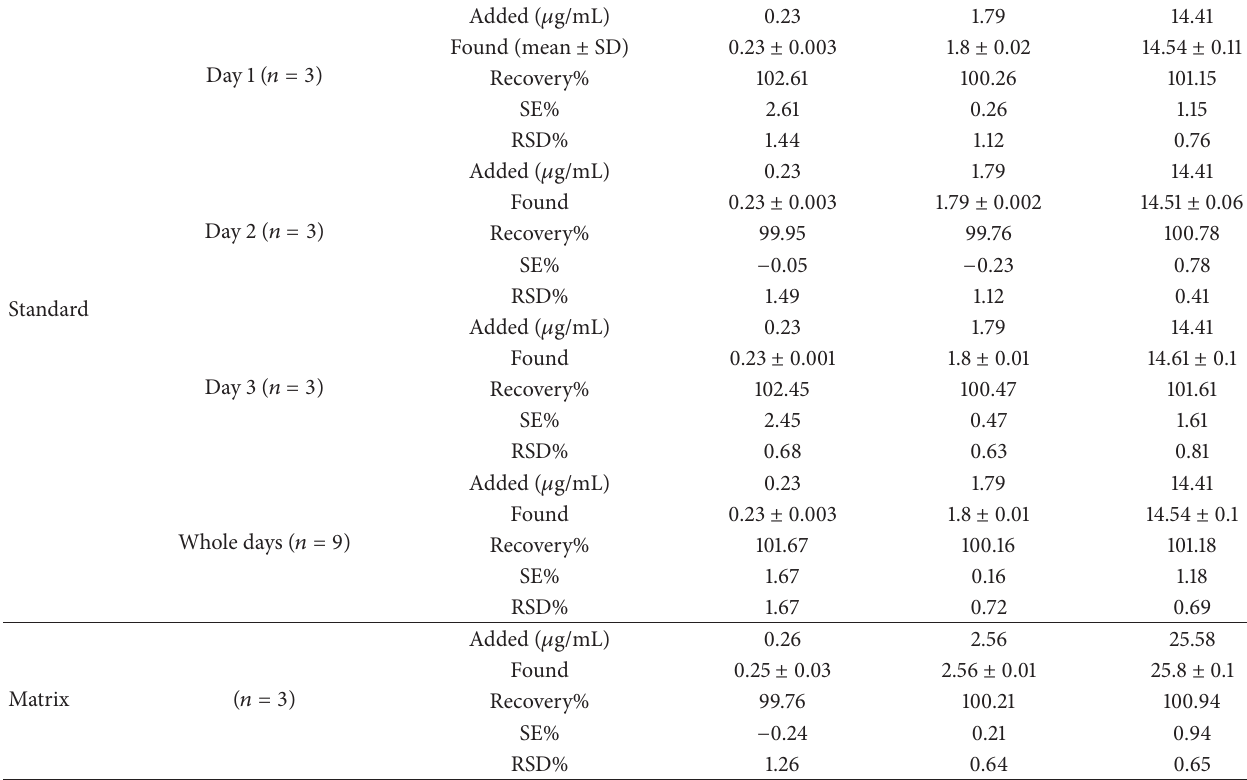
Table 3: Accuracy data for